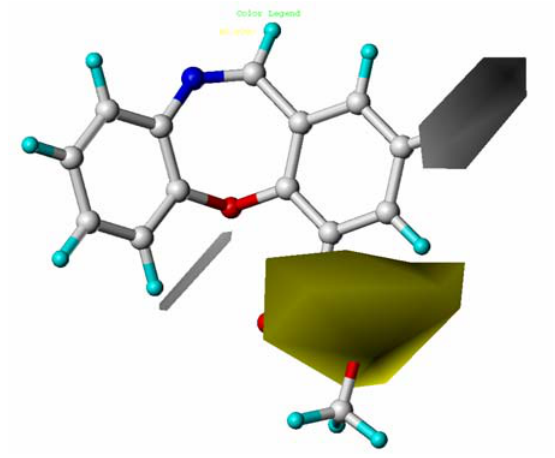
Figure 7. Contour maps of CoMSIA hydrophobic region in combination with compound 10 . Hydrophobic fields: The yellow and white (80% and 20% contributions) contours indicate favorable and unfavorable Hydrophobic groups. Compound 10 is depicted in ball and stick representation, coloured by atom type (white C, blue N, red O, cyan H)